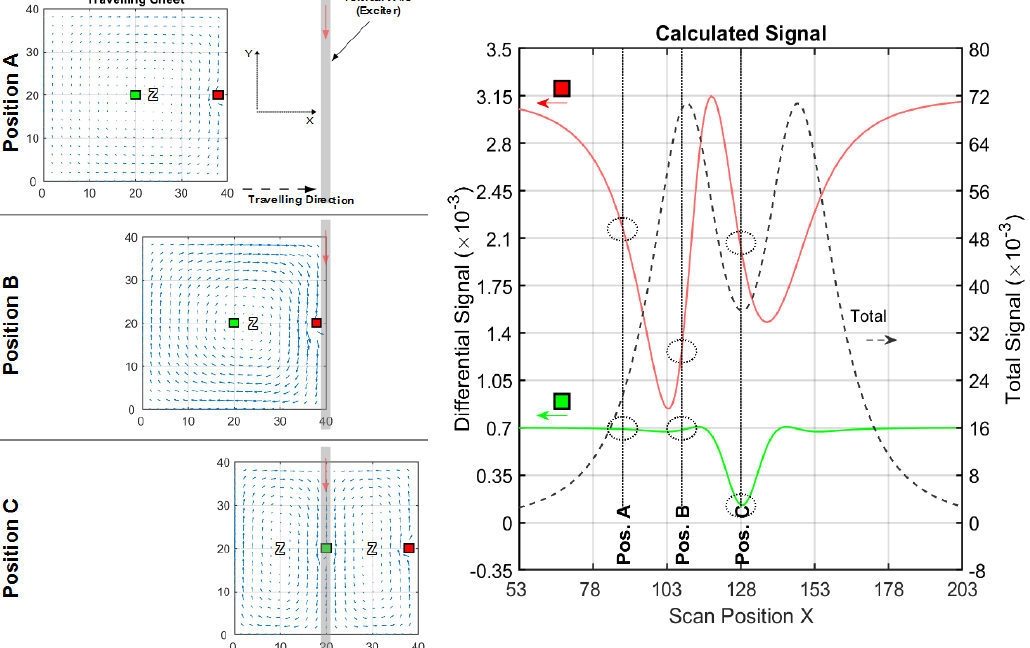
Figure 7. Current and signal calculations with a vertical wire setup (cf. Figure 3b); (left) Travelling 2D sheet with local voids (green and red) in front of a vertical wire. Blue arrows depict the current direction and intensity. Only three significant x-positions (A, B and C) are shown; (right) Total (dotted black) and differential signals for a void in the center (green) and for a void at the edge (red). T able 2. Main results from the calculated signals, shown in Figure 7.